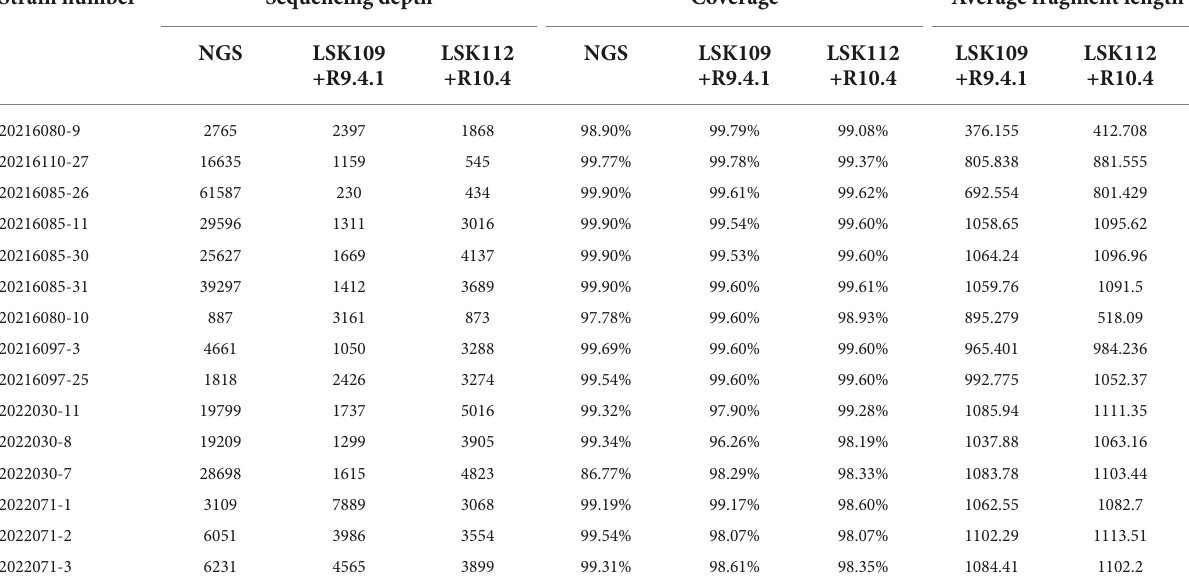
TABLE 2 Information on whole genome sequencing data from 15 samples. Strain